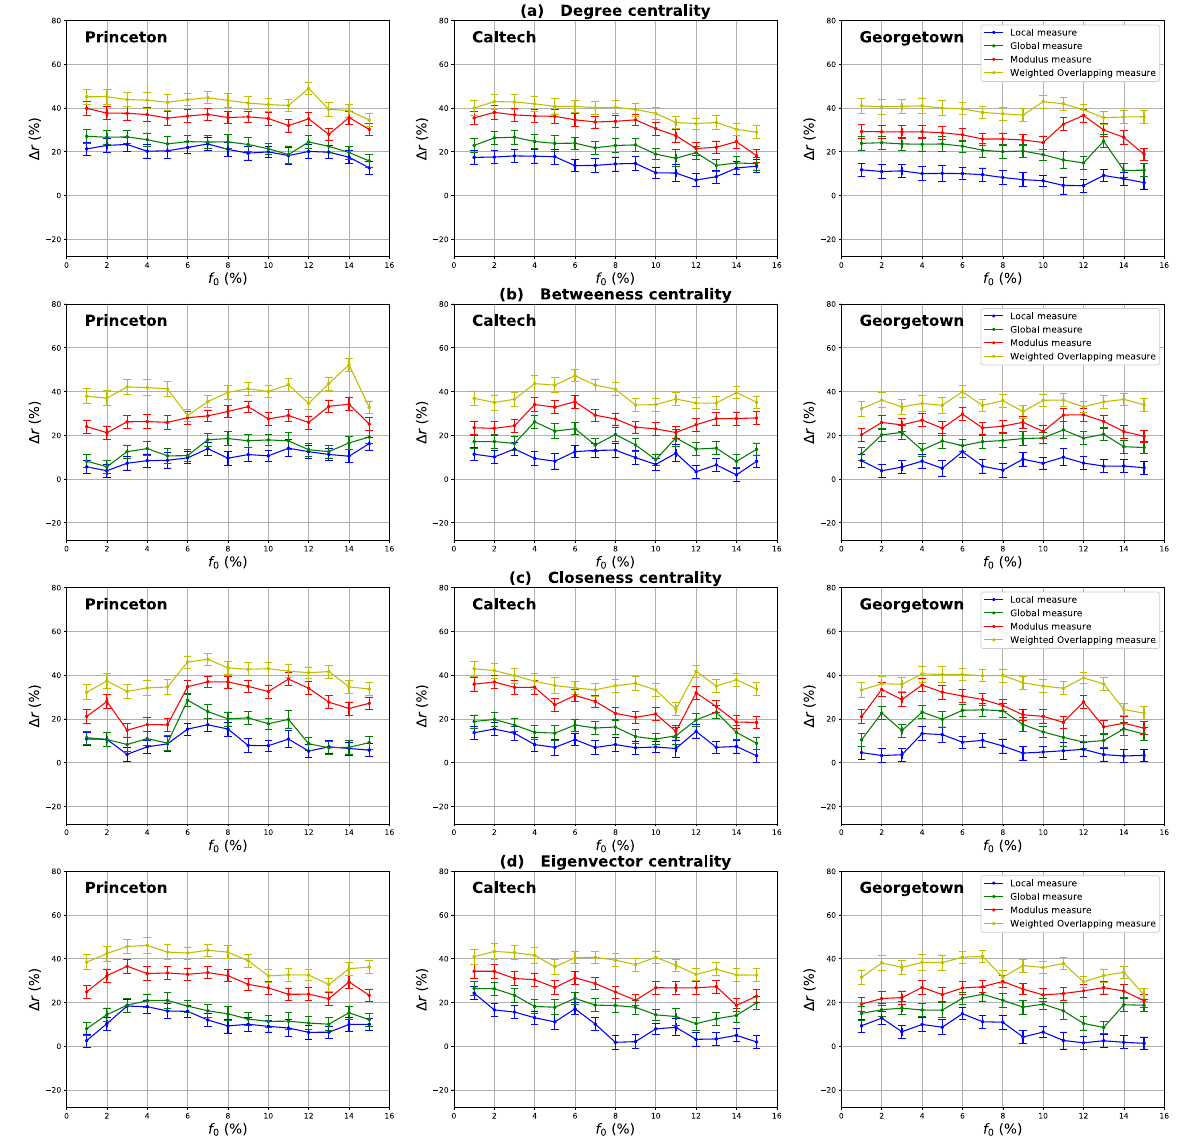
Figure 17. The relative difference of the outbreak size Δ r as a function of the fraction of initial spreaders f 0 . The Degree ( a ), Betweenness ( b ), Closeness ( c ) and Eigenvector ( d ) centrality measures derived from the Overlapping Modular centrality are compared to the standard counterpart designed for networks with no community structure. Real-world networks with medium community structure (Princeton, Caltech and Georgetown networks) are used. The estimated values of their mixing coefficient is equal respectively to 0.22, 0.26 and